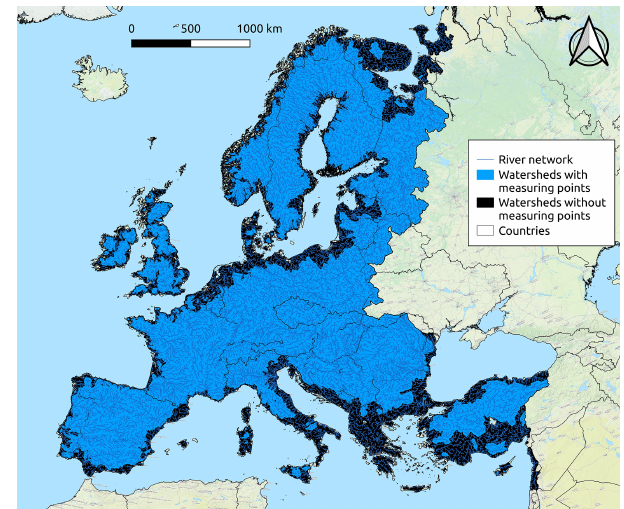
Figure 3. Merger of the elementary catchments from the DG-JRC database. Predictions have been performed for elementary catch- ments within the blue area, while no predictions have been provided for the black